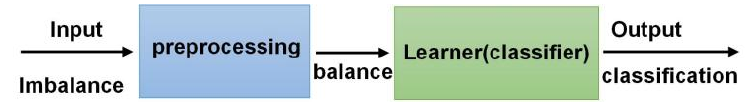
Figure 1. The approach for preprocessing before NN classifier 2.1 Data preprocessing method of random